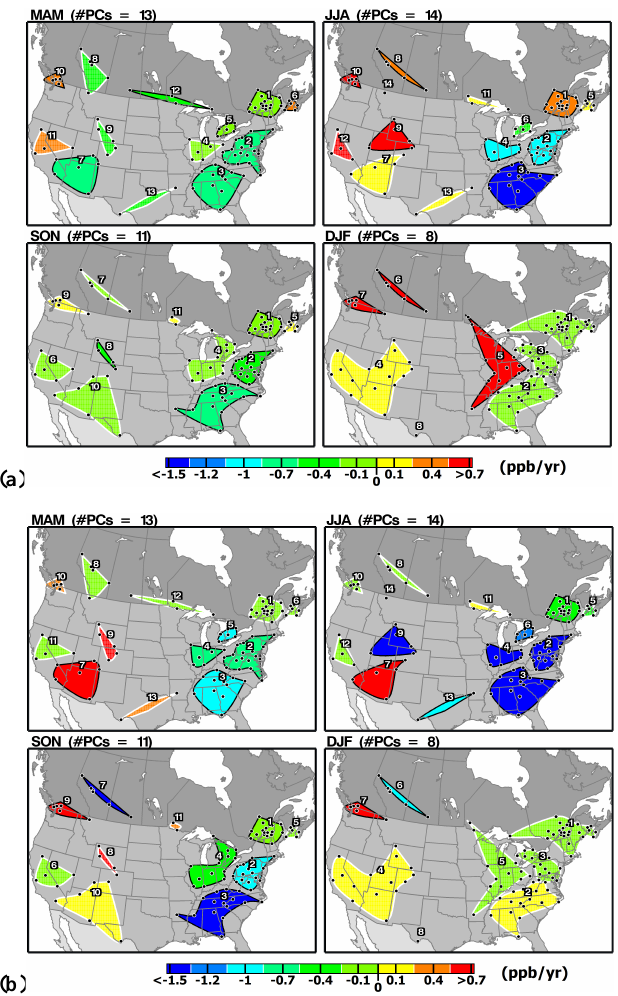
Fig. 7. (a) : Regional decadal trends of daytime (12:00–18:00LST) average ozone mixing ratios associated with the baseline air, mod- elled by GLMM for different seasons. Regions have been previ- ously defined by rotated PCA for different seasons. Significant trends at the 0.05 level are shown with a black regional boundary. The boundaries were determined by joining the outermost site lo- cations from each region. No evidence of statistical significance is shown with a white boundary. The baseline air is defined as the air parcel trajectories associated with the lowest May–September 95th percentile ozone mixing ratios at a given site. (b) : Regional decadal trends of daytime (12:00–18:00LST) average ozone mixing ratios associated with the most polluted air, modelled by GLMM for dif- ferent seasons. The most polluted air is defined as the air parcel trajectories associated with the highest May–September 95th per- centile ozone mixing ratios at a given